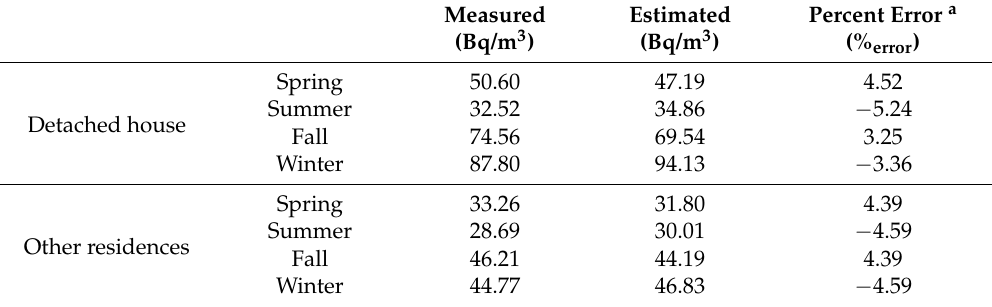
Figure 2. Monthly geometric mean of estimated indoor radon concentrations (Bq/m 3 ) calculated from Equation (7) for different types of houses. Table 4. Measured and predicted seasonal variations in indoor radon concentration calculated from Equation (7) for different types of houses.